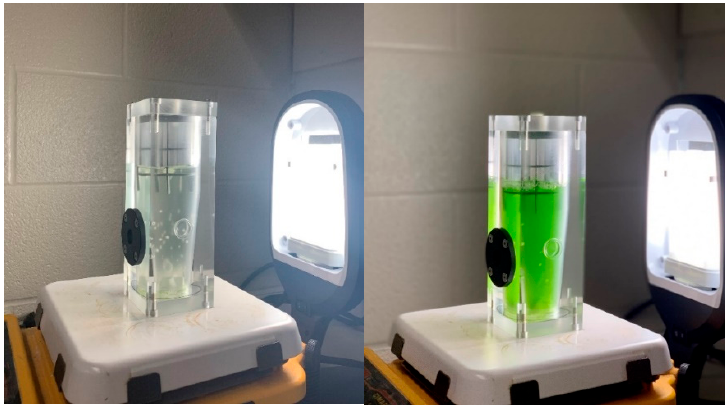
Figure 1. Different stages of CPCC90 Chlorella vulgaris growth in a PhotoBioCREC